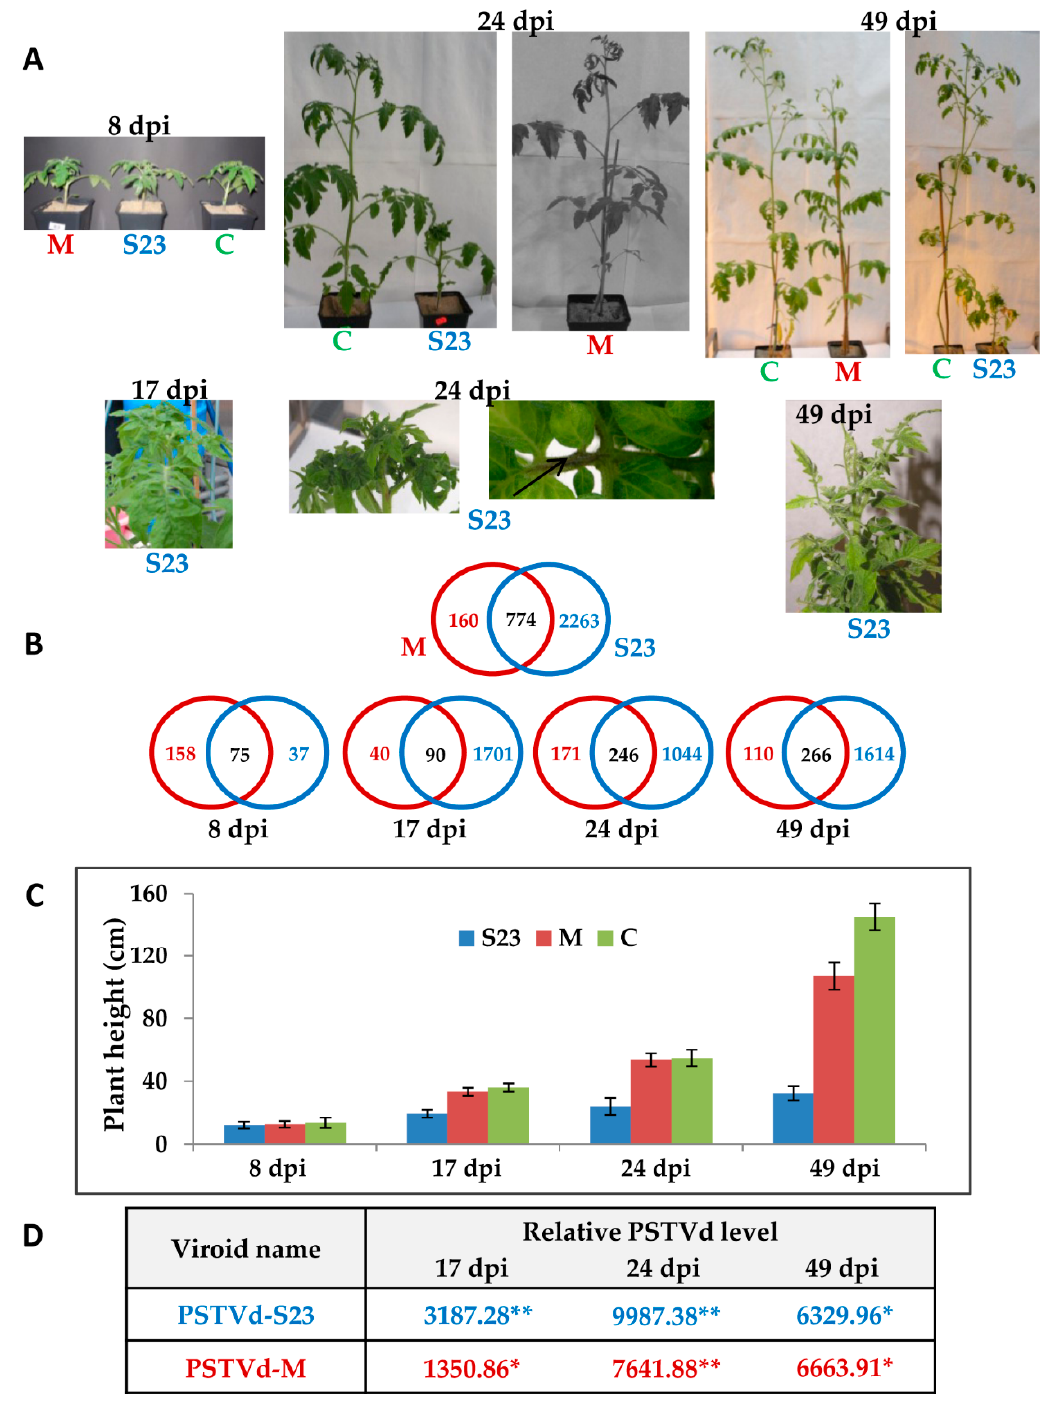
Figure 1. Time course of symptom development of PSTVd infection on “Rutgers” tomato in correlation with viroid RNA level and number of DEGs. ( A ) Comparison of symptoms induced by the mild and severe PSTVd variants. Typical necrosis caused by S23 at 24 dpi are indicated by arrow. ( B ) Venn diagrams of the DEGs: total DEGs in M and S23 infected plants, and at the indicated time points. ( C ) Comparison of plant heights at 4 time points. Each bar represents the arithmetic mean of the height of three plants with SD indicated. C, control plant (pUC9 vector-inoculated). ( D ) Relative viroid level measured by the NanoString nCounter method. Relative viroid level in arbitrary units in comparison to control plants was estimated using nSolver analysis software (v. 3.0, NanoString Technology, Seattle, WC, USA). A t -test was used to determine the significance of the differences; * and ** indicate p < 0.05 and p < 0.001, respectively.